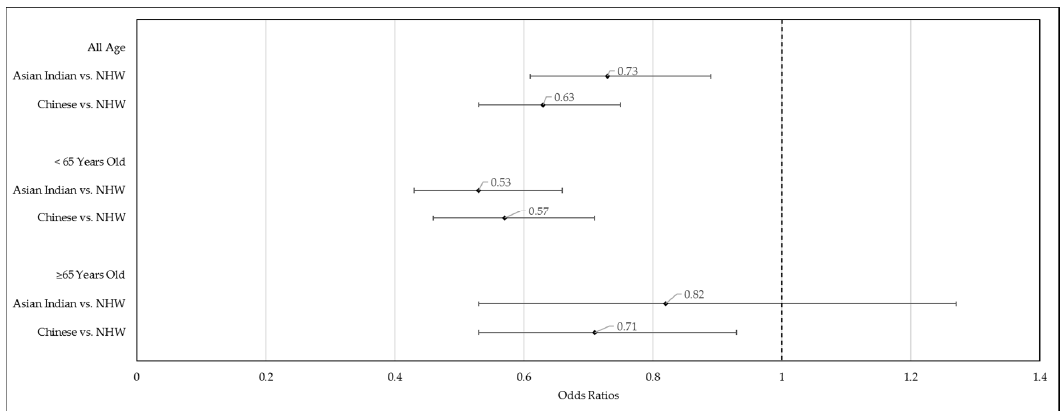
Figure 2. Adjusted Odds Ratios (AOR) and 95% Confidence Intervals (CI) of racial / ethnic categories from logistic regression on multimorbidity among Asian Indian, Chinese, Non-Hispanic White (NHW) adults (age ≥ 18 years) stratified by age group ( < 65 years vs. ≥ 65 years). National Health Interview Survey, 2012–2017.